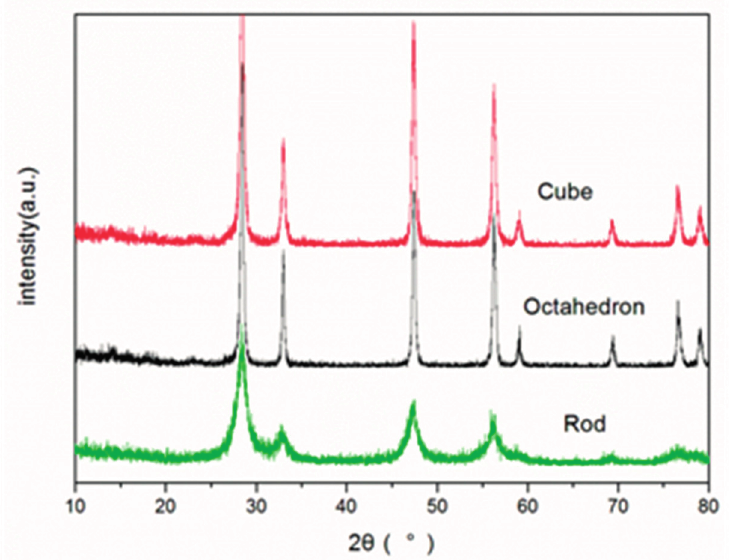
Figure 1. The XRD patterns of nano-CeO 2 synthesized by hydrothermal